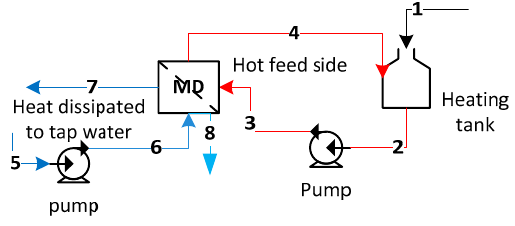
Figure 4. Water and heat streams considered in the Elixir500 AGMD lab unit.